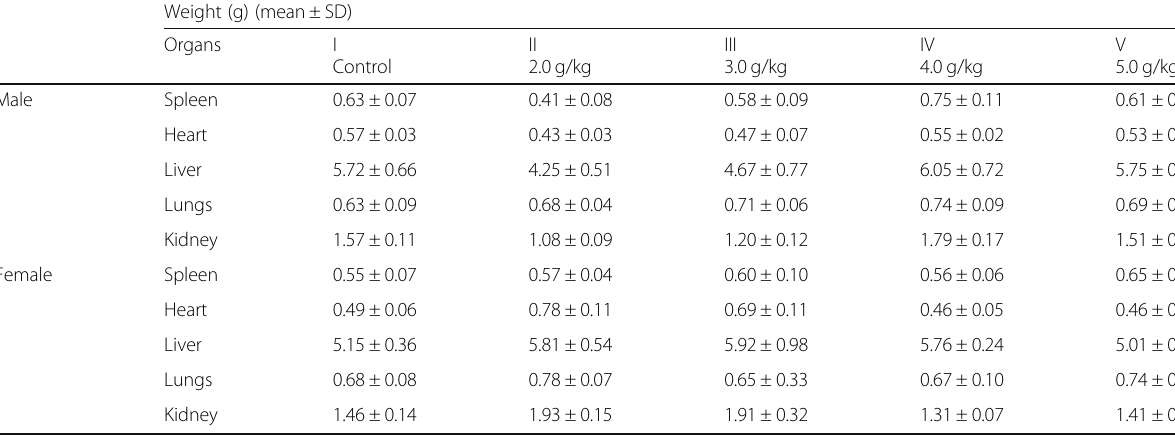
Mean values are not significantly different ( p ≥ 0.05), n